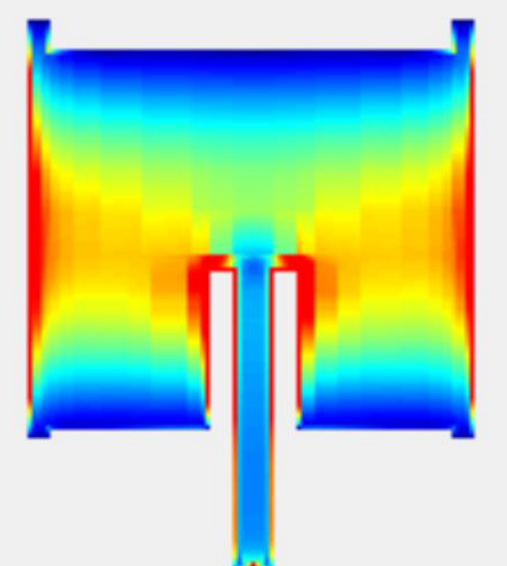
Figure 5. Current distribution of proposed antenna design at